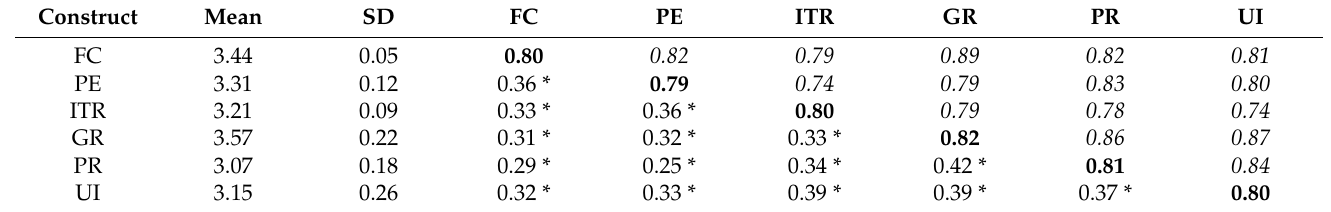
Table 3. Discriminant validity (Fornell–Larcker Criterion and Heterotrait-Monotrait ratio